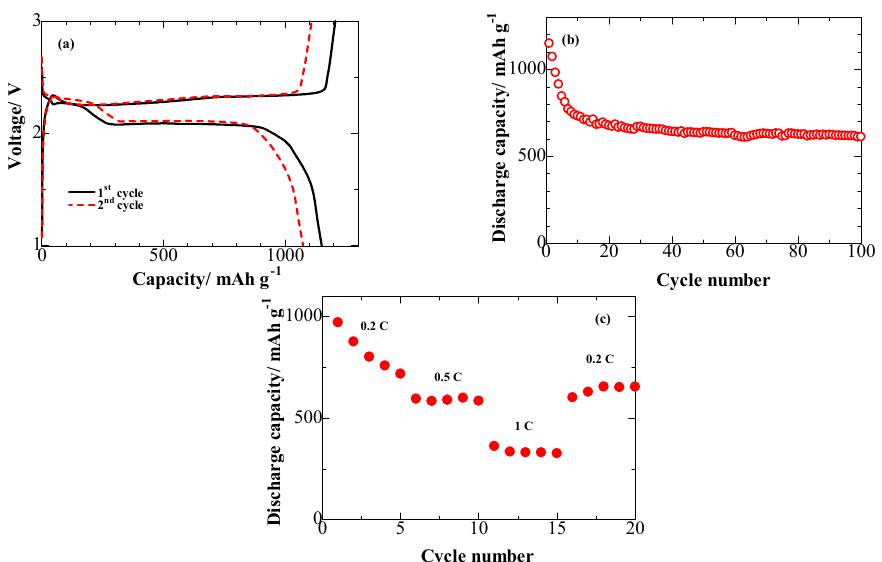
Figure 5. ( a ) The galvanostatic discharge/charge profiles of a lithium cell with the S/ONPC composite, ( b ) Cycle performance of a lithium cell with the S/ONPC composite for 100 cycles at 0.2 C, ( c ) Rate capability of a lithium cell with the S/ONPC composite.